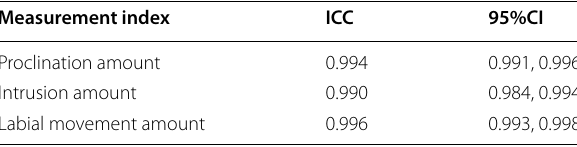
Table 1 Characteristics of study population